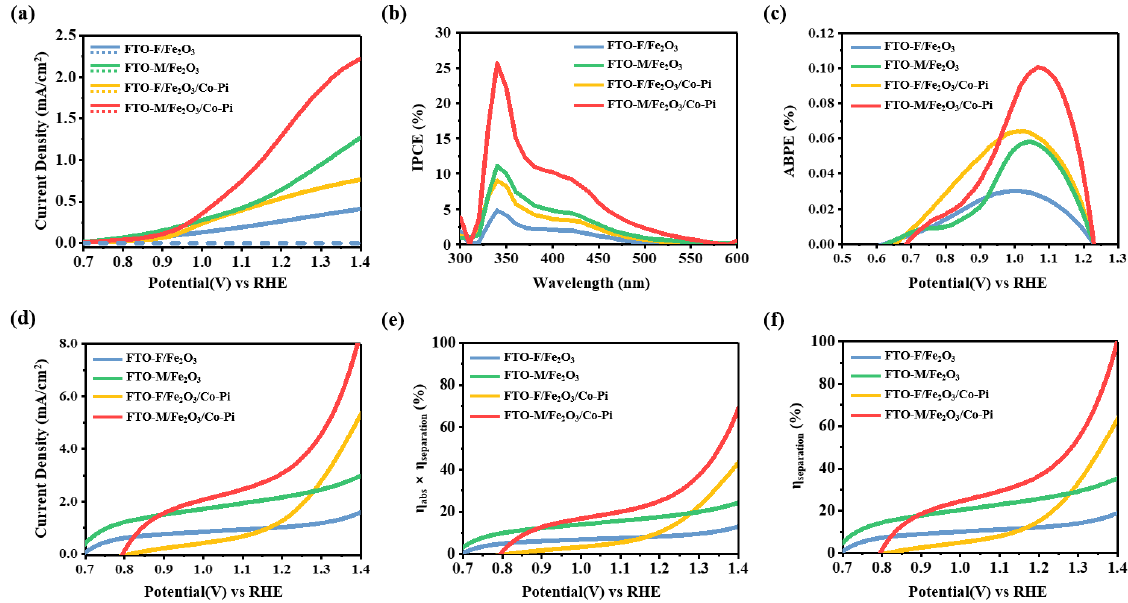
Figure 5. Photoelectrochemical (PEC) performance characteristics of FTO-F/Fe 2 O 3 , FTO-M/Fe 2 O 3 , FTO-F/Fe 2 O 3 /Co – Pi, and FTO-M/Fe 2 O 3 /Co – Pi. ( a ) J – V curves in 1 M of NaOH under illumination. ( b ) IPCE measured at 1.23 V RHE . ( c ) ABPE calculated from J – V curves. ( d ) J H₂O₂ – V curves measured in 0.1 M of NaOH with 0.5 M of hydrogen peroxide (H 2 O 2 ) under illumination. ( e ) Absorption effi- ciency multiplied by the charge separation efficiency (η abs × η separation ). ( f ) Charge separation effi- ciency (η separation ).